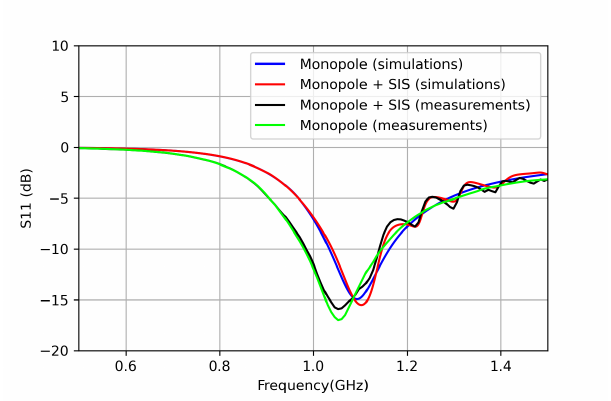
FIGURE 4. Reflection coefficient of the SIS mockup comprising two Rogers TMM6 layers (measurements and simulations)